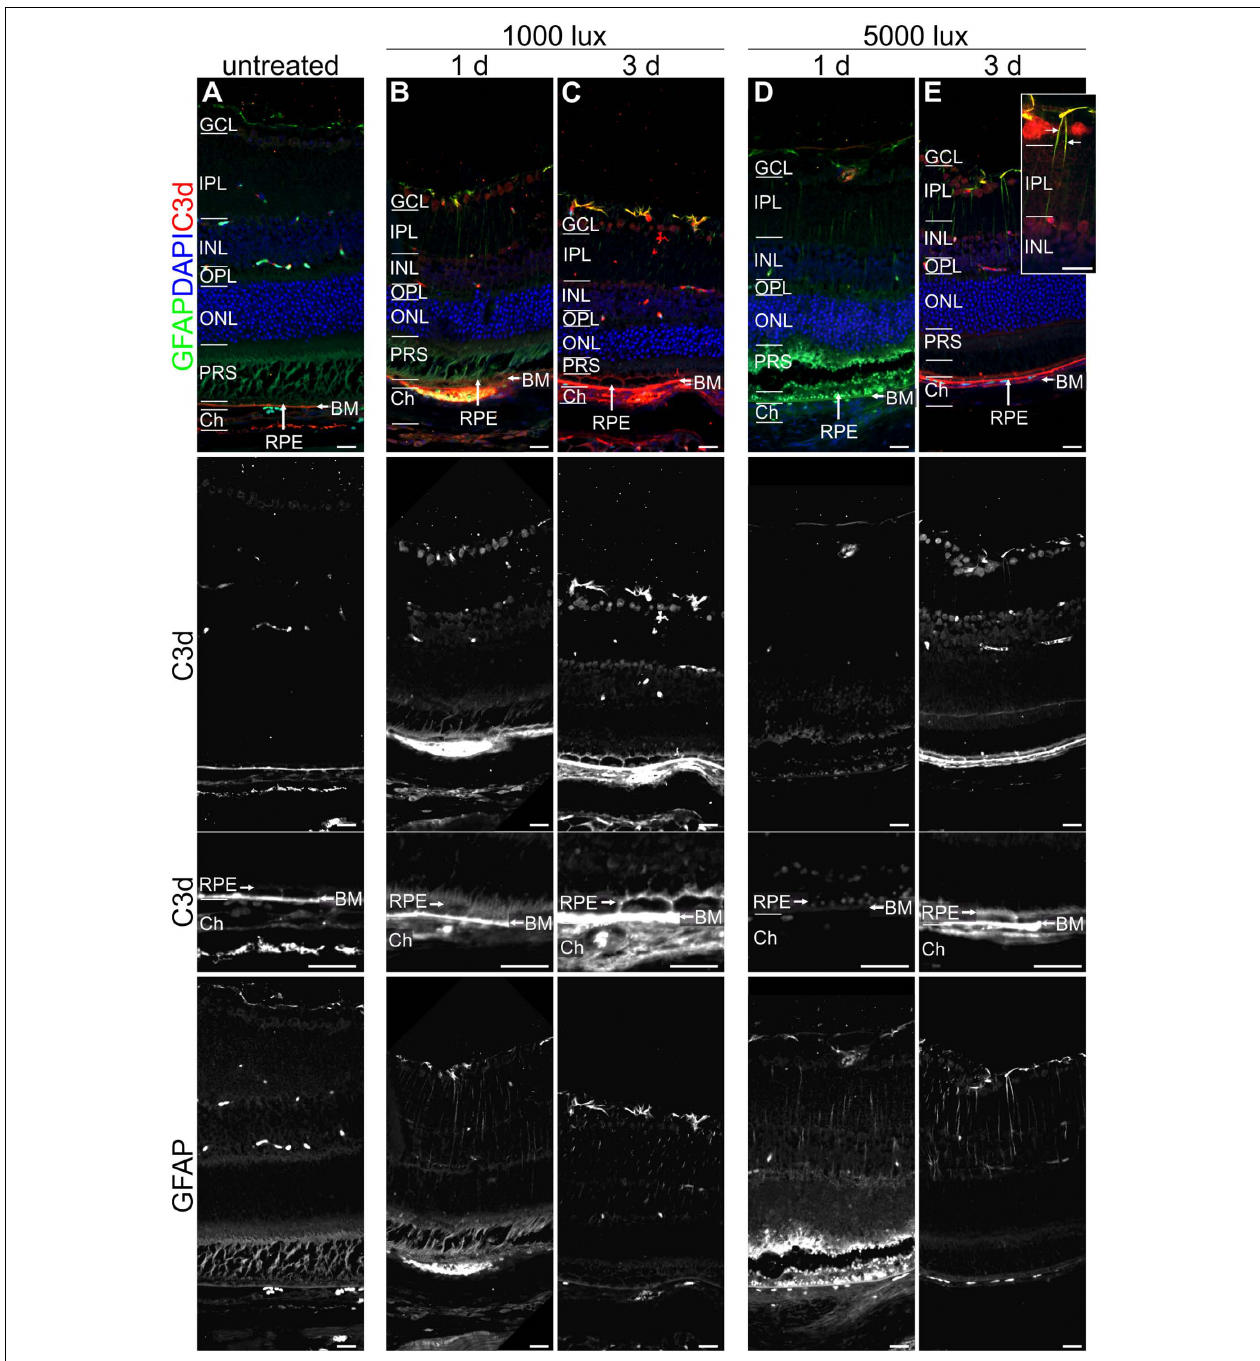
FIGURE 5 | Reactive Müller cells, astrocytes and RPE are co-localized with C3d in LD retinae. Immunolabelled mouse eye sections for C3d (red) and GFAP (green) showed a LD-dependent Müller cell and astrocyte activation (GFAP, green) as well as complement activation (C3d, red), irrespective of light intensity and recovery time. (A) Untreated mouse retinae were negative for gliosis and showed a distinct C3d-dependent staining of Bruch’s membrane. (B–E) Retinae treated with bright light depicted an increased GFAP-staining of Müller cells and astrocytes which was partly co-localized with C3d staining in the retina. C3d staining at the RPE/Bruch’s membrane was increased after light treatment and additionally deposited at the surface of RPE cells. Retinal layers from the top to the bottom: GCL, ganglion cell layer; IPL, inner plexiform layer; INL, inner nuclear layer; OPL, outer plexiform layer; ONL, outer nuclear layer; PRS, photoreceptor segments; RPE, retinal pigment epithelium; BM, Bruch’s membrane; Ch, choroid. Scale bars, 20 µ m.